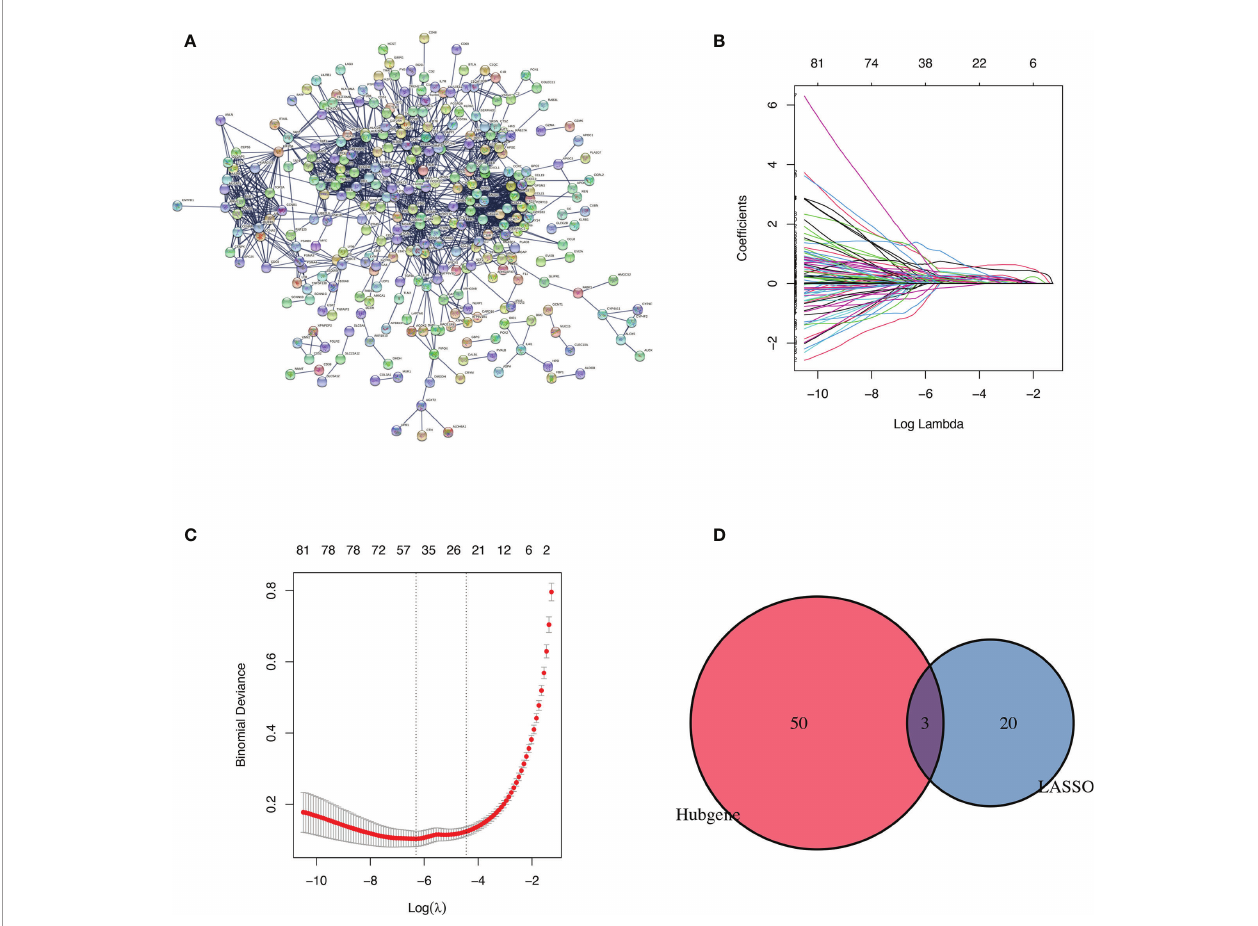
FIGURE 2 | Identi fi cation of diagnostic markers. (A) Protein-protein interaction network of DEGs. (B, C) identi fi cation of biomarkers using the LASSO regression algorithm. (D) Venn diagram demonstrating three markers shared by PPI network and the LASSO regression